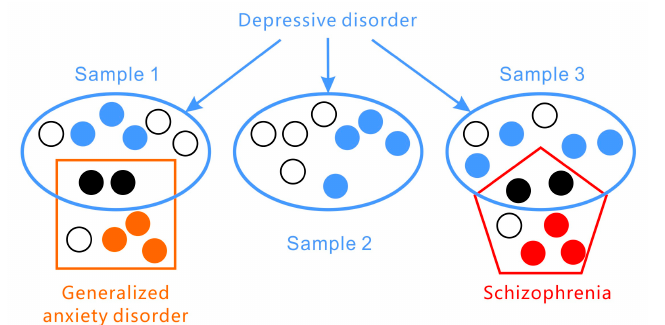
Figure 1. Depressive disorders vary greatly in their presentation of symptoms and are co-morbid with other disorders (such as generalized anxiety disorder and schizophrenia).